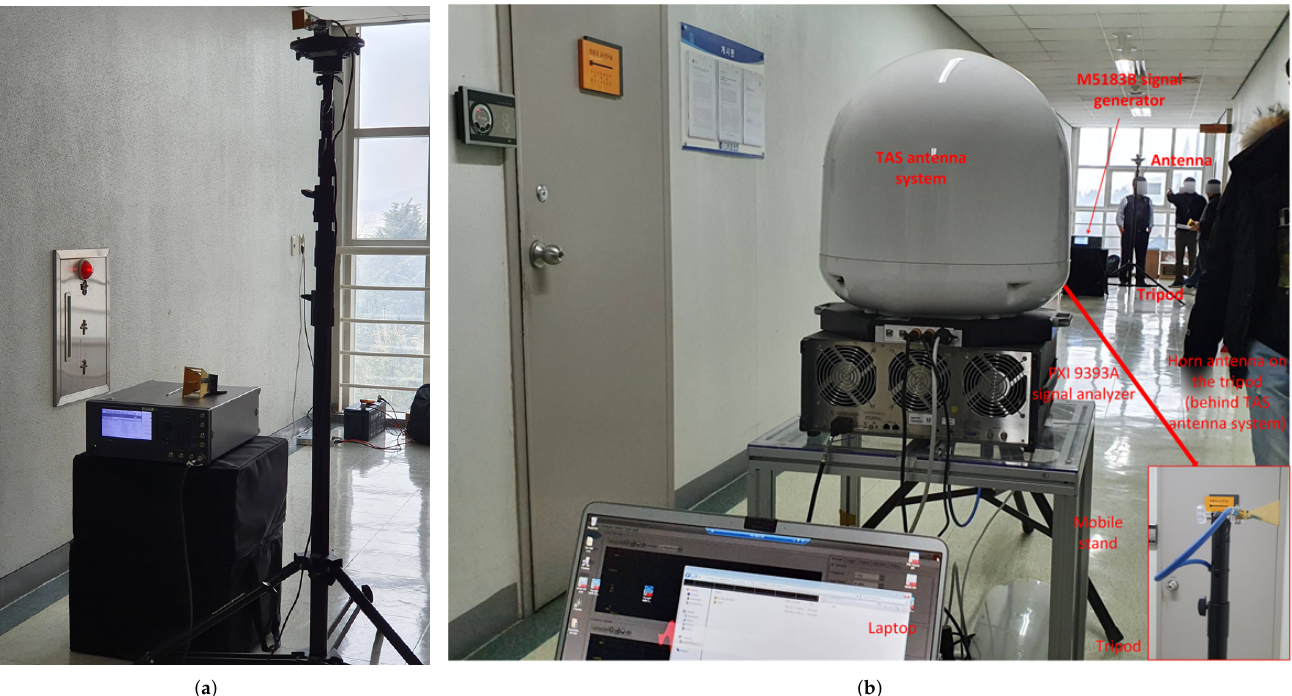
Figure 4. ( a ) The figure shows the location of the transmitter of the measurement campaign in the corridor of the IT convergence building on the 10th floor. The 1.75 m height transmitter was installed at 4.3 m along the wall; ( b ) the figure shows a measurement location while moving the receiver in a particular position along the corridor of the IT convergence building on the 10th floor. The picture includes the Rx horn antenna and the TAS